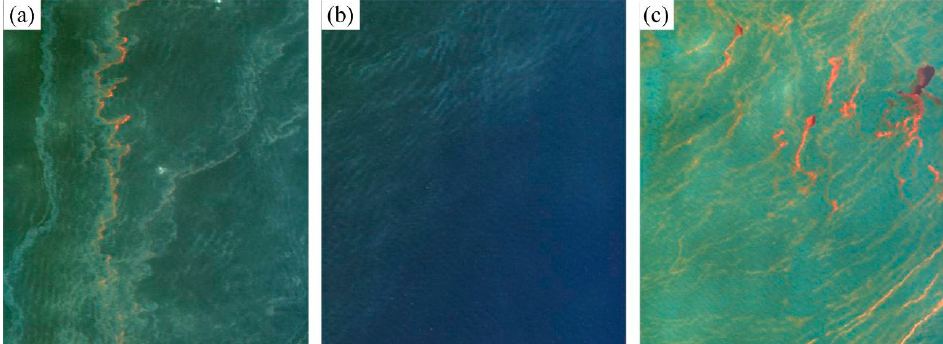
Figure 2. Three training images used to evaluate the ability of spectral indices to identify diverse thicknesses of oil slicks. Pictures ( a – c ) are false-color composited training images ( a – c ).